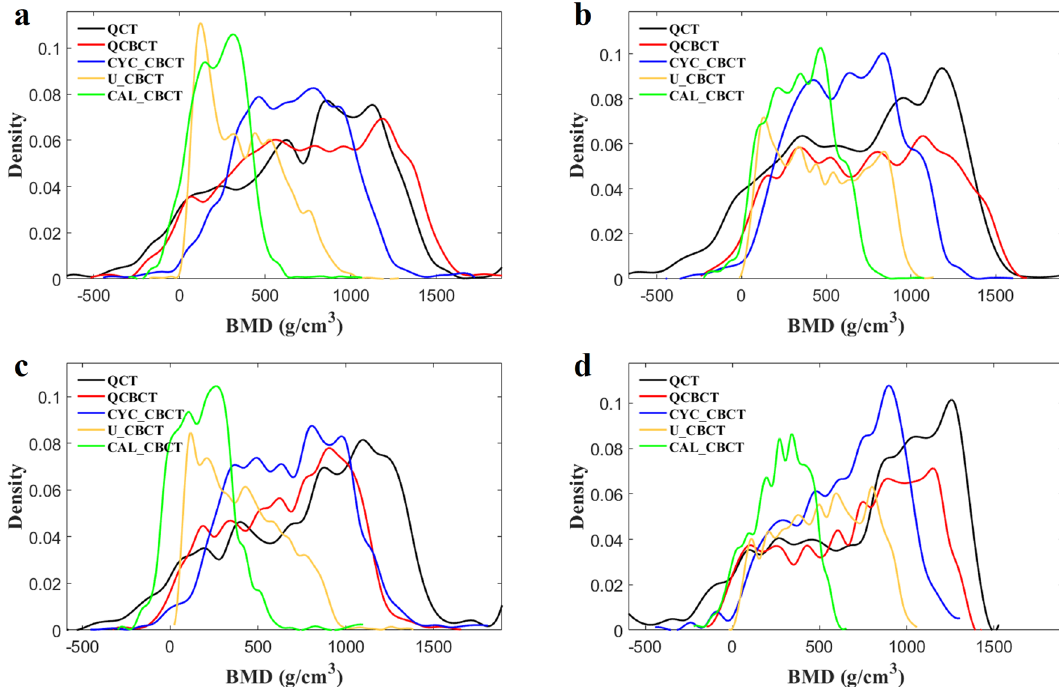
Figure 5. The BMD distribution in an axial slice of the original QCT, and QCBCT, CYC_CBCT, U_CBCT, and CAL_CBCT images. ( a ) CBCT images at the maxilla under condition of 80 kVp and 8 mA, ( b ) at the mandible under condition of 80 kVp and 8 mA, ( c ) at the maxilla under condition of 90 kVp and 10 mA, and ( d ) at the mandible under condition of 90 kVp and 10